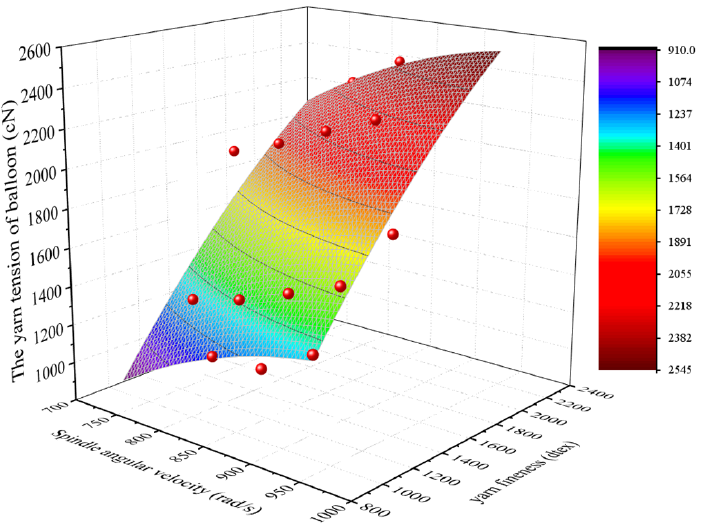
Figure 8. Fitting surface of the relationship between yarn tension of the balloon, spindle angular velocity, and yarn fineness.